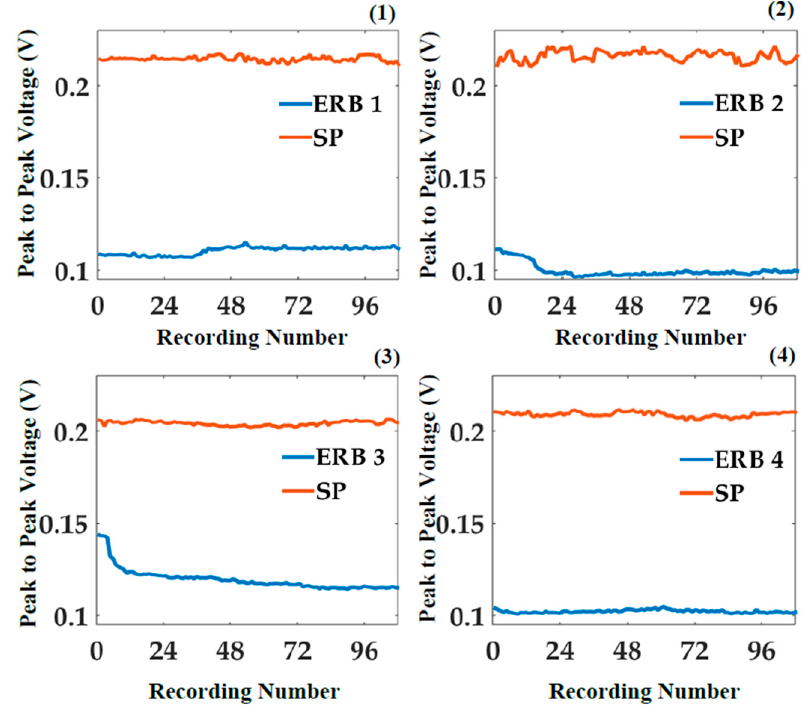
Figure 6. Peak-to-peak voltage comparison of the ERBs and the SP. ( 1 ) to ( 4 ) refer to the different